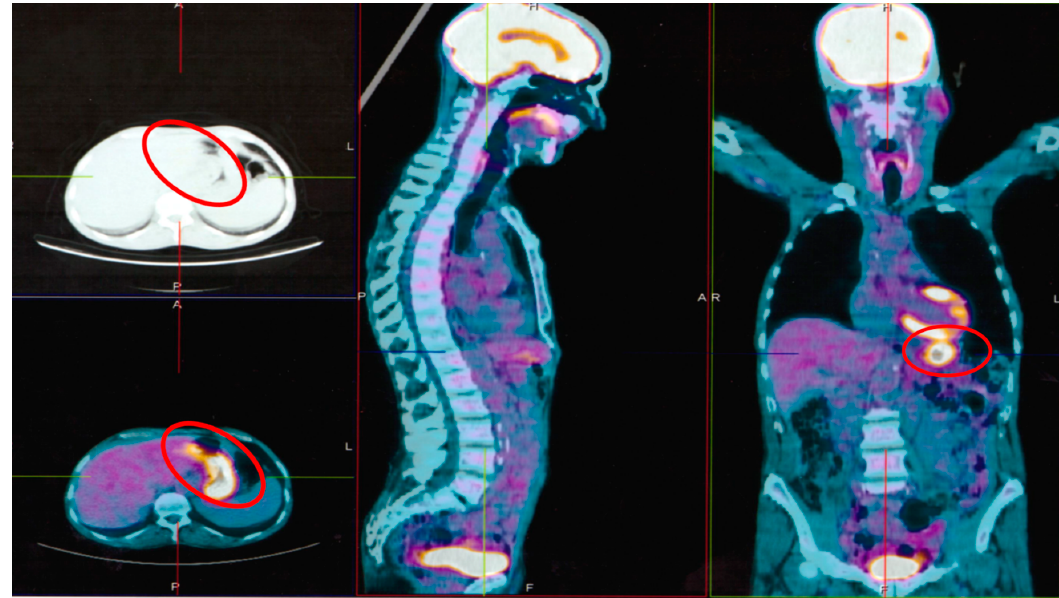
Figure 1. [18F] FDG-PET performed with co-registered CT at the diagnosis (February 2018) show significant areas (indicated in red circles) of increased metabolic activity in abdominal cavity loaded with solid tissue (23 × 14 × 4 cm) which occupies the whole of the mesentery and the retroperitoneal space by displacing the pancreas anteriorly and the intestinal loops laterally (SUV 4.85).